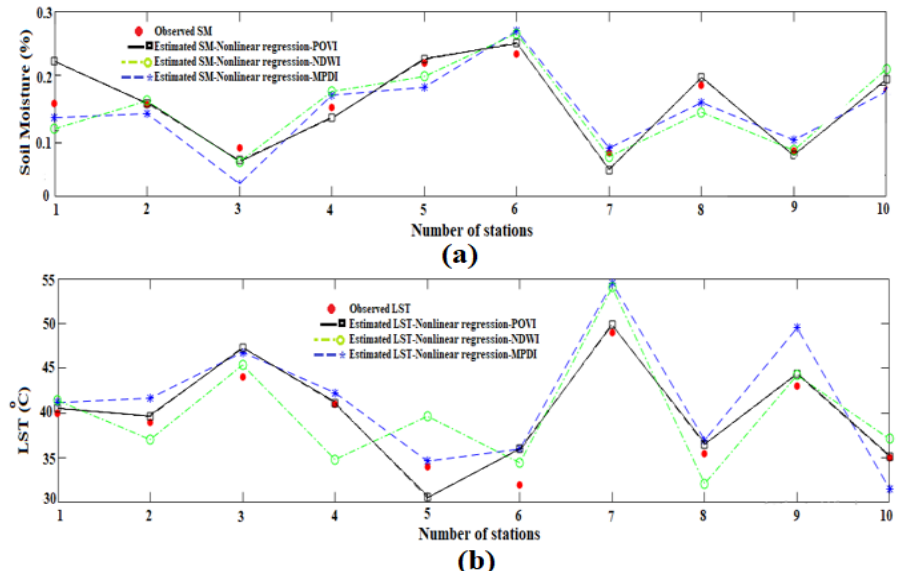
Figure 7. Comparison between observed and estimated Soil moisture ( a ) and Land surface temper- ature ( b ) parameters using POVI , MPDI and NDWI in nonlinear relationship.